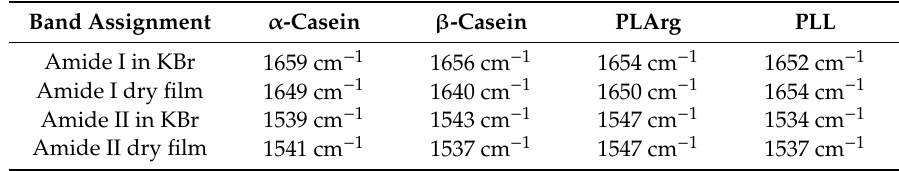
Figure 4. FTIR spectra of α -casein, β -casein, PLL and PLArg ( A ) in KBr and ( B ) dry films on germanium crystal—by VariGATR. Table 2. The positions of the maxima of amide absorption bands measured in KBr pellets and in dry film at Ge